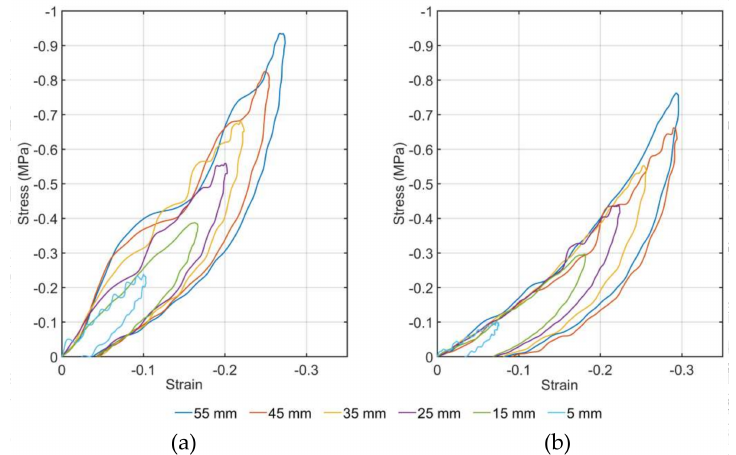
Figure 5. Stress-strain curves for the first drop for each drop height for ( a ) Berleburger and ( b ) Holywell